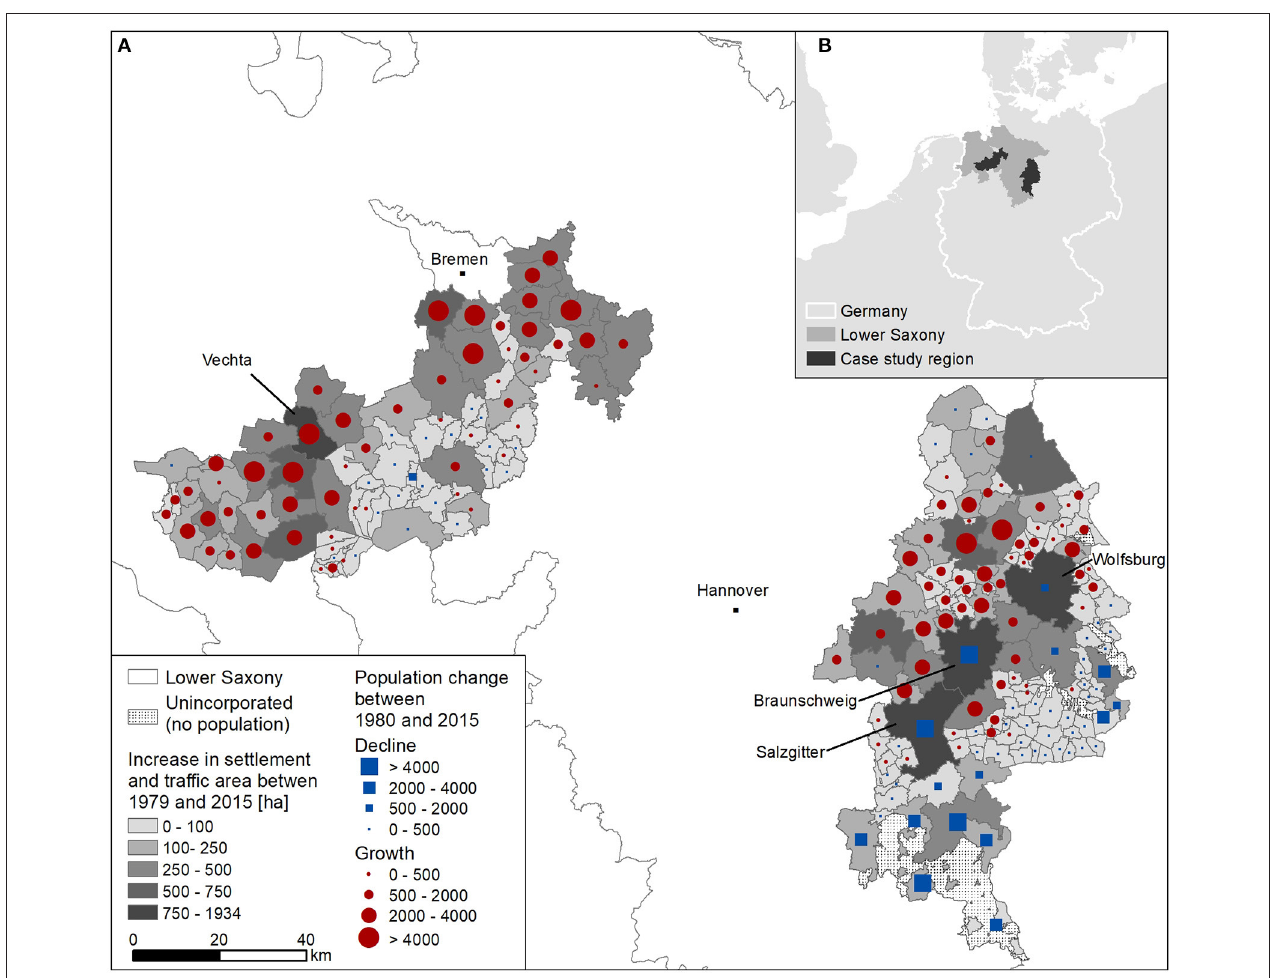
FIGURE 1 | Land consumption (increase of settlement and traffic area) between 1979 and 2015 is shown in grayscale, population decline between 1980 and 2015 in blue squares, population increase between 1980 and 2015 in red circles (A) . Land consumption is widespread and even occurred in municipalities with population decline. The case study area in Lower Saxony (B) . Data A: ESRI basemap Europe and BKG (2016). Data B: LSN (2018) and BKG